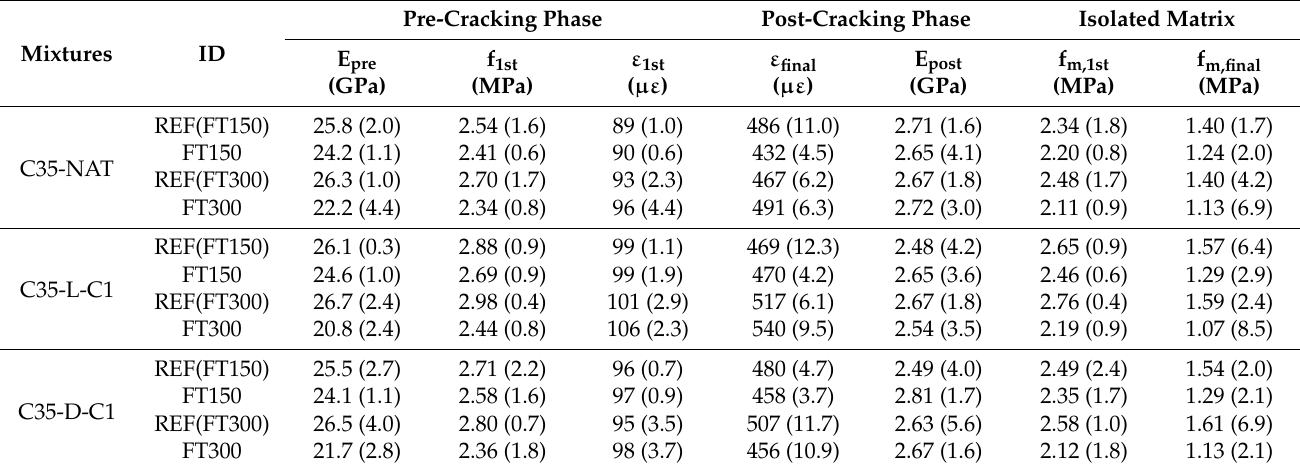
Table 3. Main representative parameters for tested reinforced elements subjected to freeze-thaw cycles.